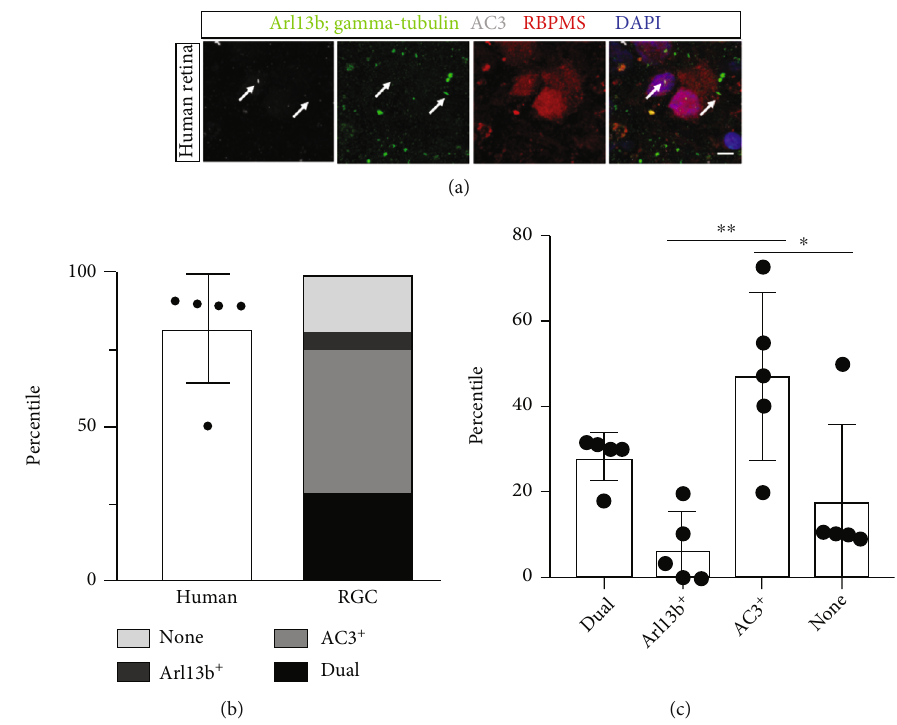
Figure 6: Ciliated AC3-positive RGCs are identi fi ed in human retina. (a) Representative images illustrating 68-year-old human retina immunostained with the neuronal ciliary marker, AC3 (gray), Arl13b and gamma-tubulin cilia marker (both in green). RGCs are marked by RBPMS (red), and nuclei are stained with DAPI (blue). White arrows indicate primary cilia. (b) Quanti fi cation of the population percentages of 4 subtypes of RGCs de fi ned by ciliary markers. (c) Quanti fi cation of the populations of 4 subtypes of RGCs shows that AC3-positive ciliated RGCs are the most abundant (One-way ANOVA). Scale bar: 10 μ m; magni fi ed, 1 μ